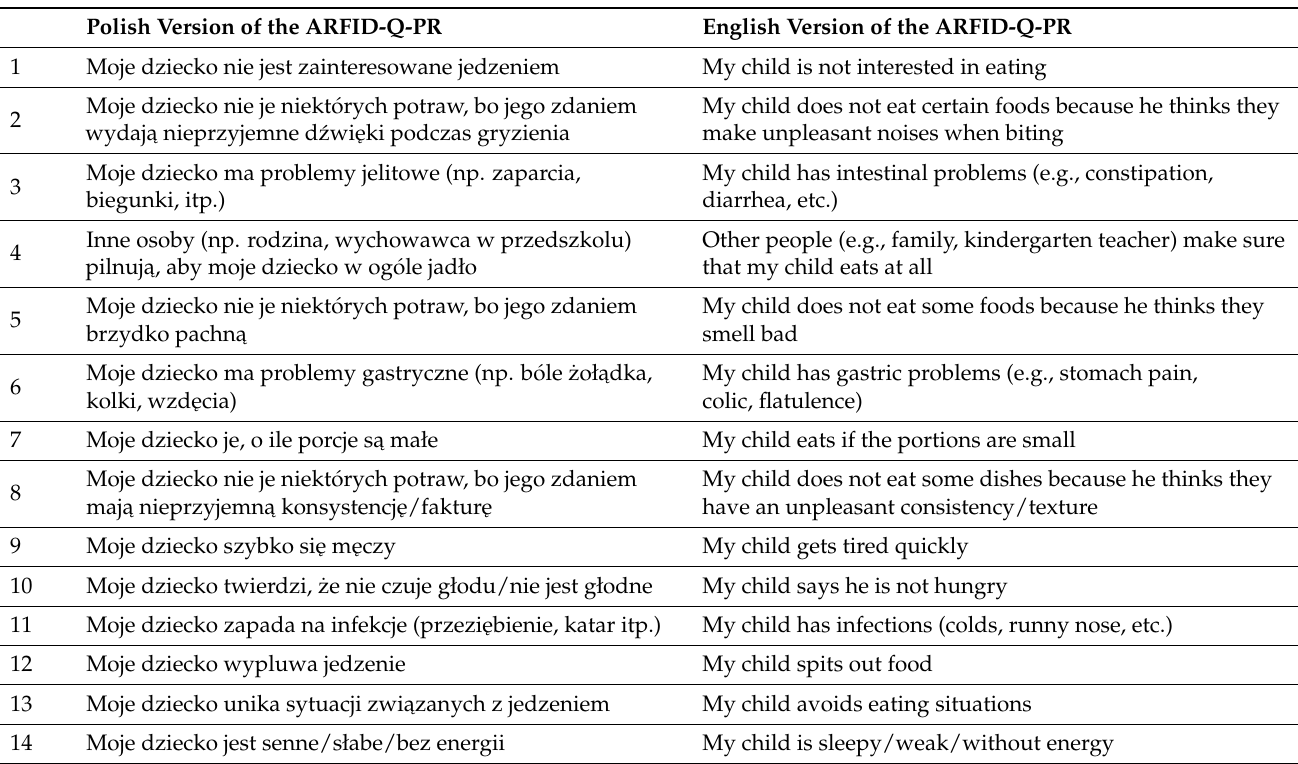
Table 3. The ARFID Questionnaire—Parent Report (ARFID-Q-PR): Polish and English